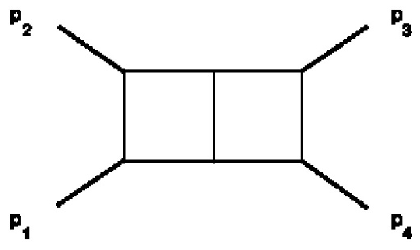
Figure 8. A six-denominator two loop sector.